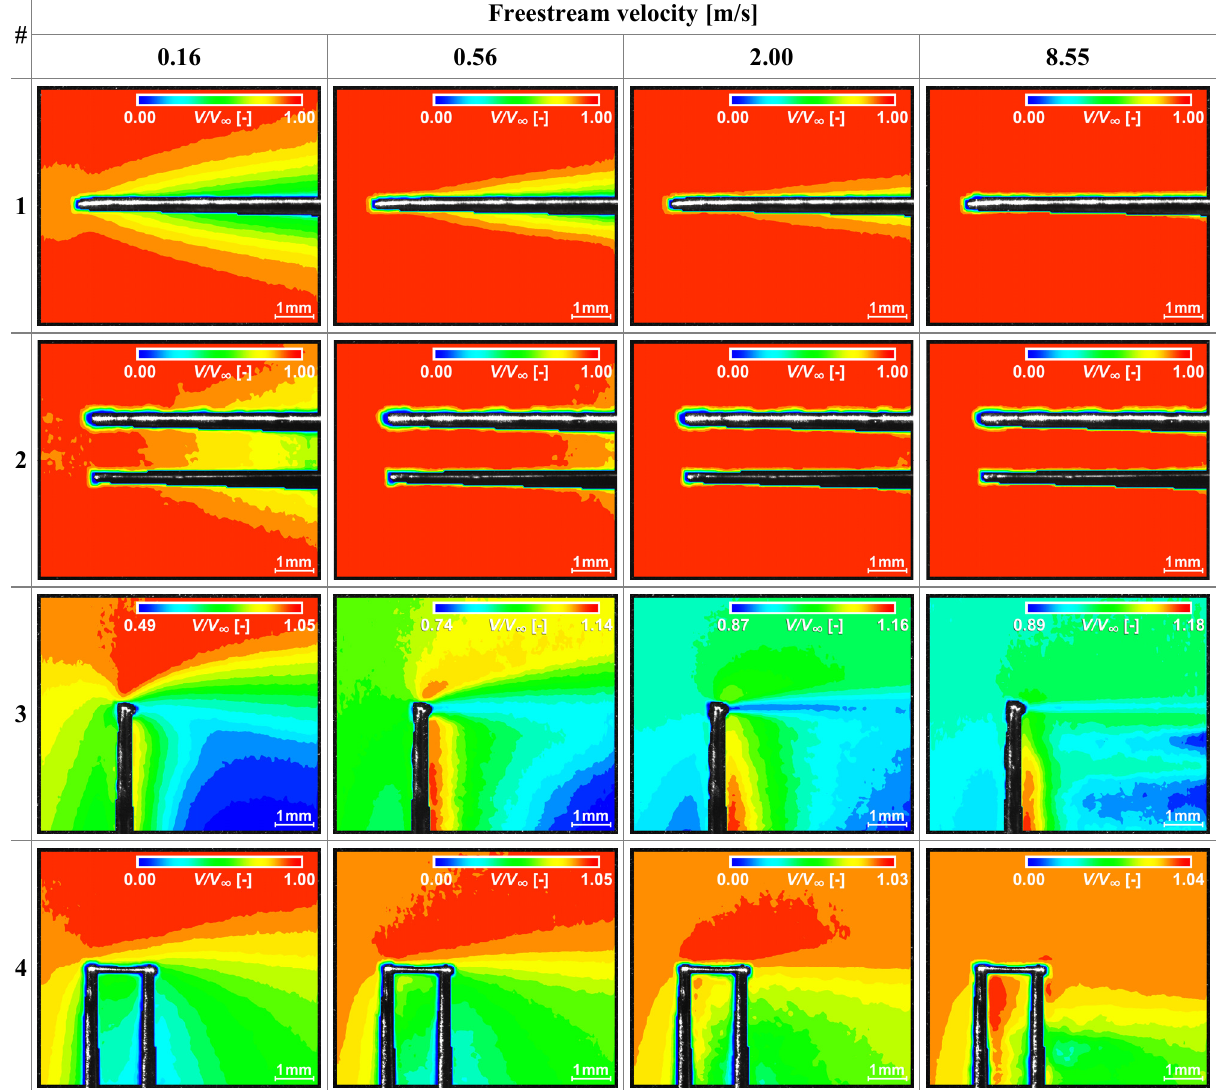
Fig. 5. Contour plots of the averaged (over time) fields of the velocity magnitude. Plots in columns relate to this same freestream velocity, whereas in rows relate to this same orientation in